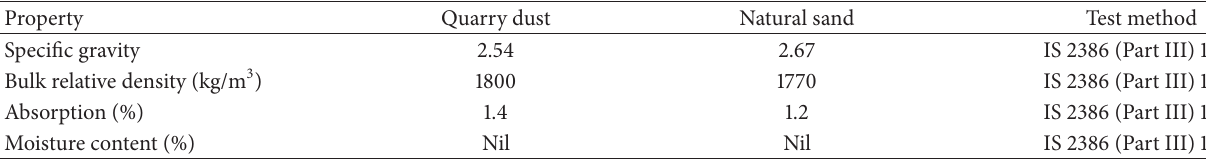
Table 4: Physical properties of quarry dust and natural sand.